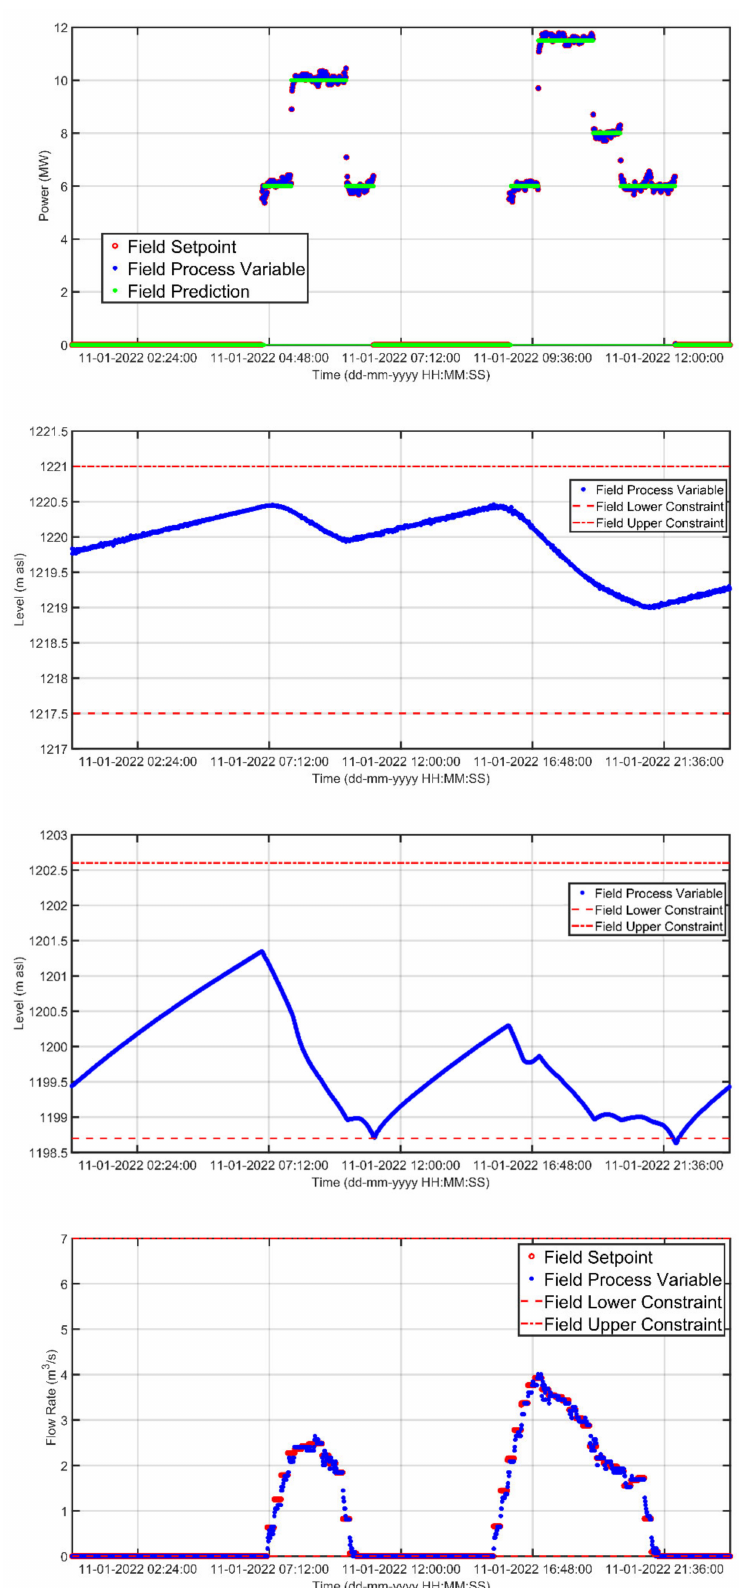
Figure 18. Field results: electric energy production, upstream reservoir, downstream reservoir, and Beikircher regulation